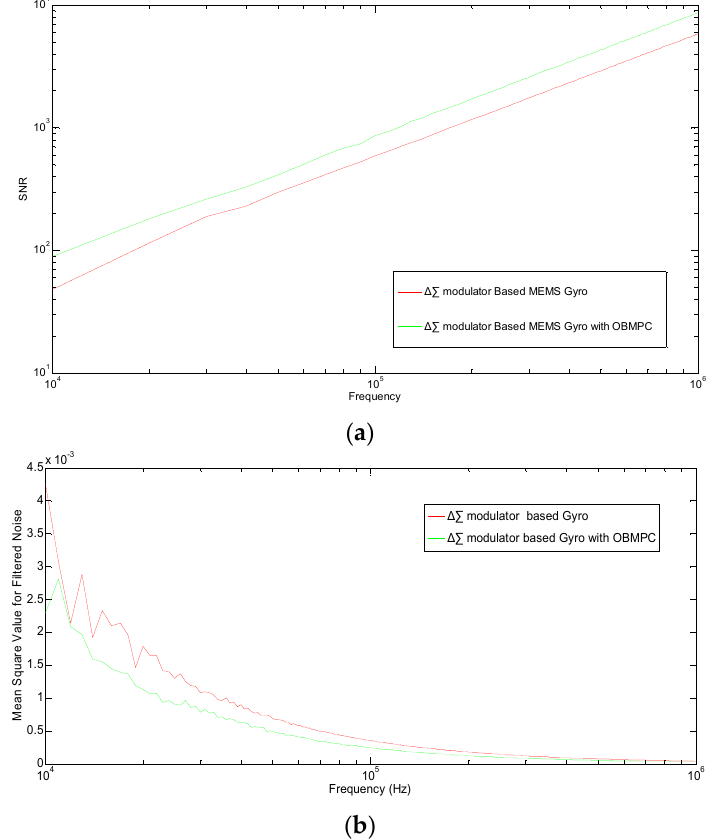
Figure 13. ( a ) SNR and ( b ) MSE of the quantization noise with different sampling frequency. It can be seen that under high sampling frequencies ( > 10 (cid:2872) Hz ), the OBMPC-based MEMS gyroscope provide better SNR and lower noise level than its benchmark due to the use of MPC controller. Moreover, since the amplitude of the modulator input signal is important to the performance of the Δ∑ modulator based system, the SNR and MSE of the quantization noise under different input signal amplitudes are obtained as shown in Figure 14.